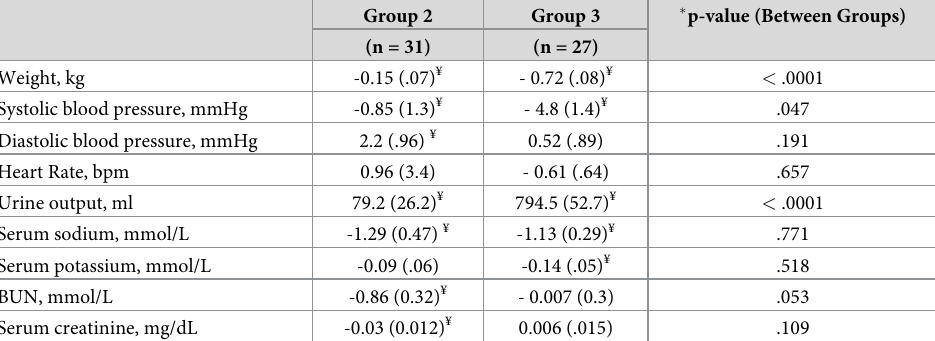
Table 2. Infusion visit metrics changes (post infusion-pre infusion) categorized by intervention group. Group